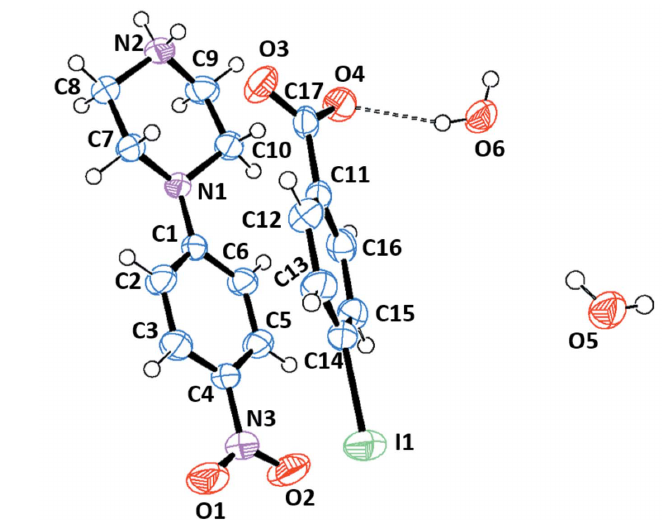
Figure 2 The independent components of compound (II) showing the atom- labelling scheme and the hydrogen bonds, drawn as dashed lines. Displacement ellipsoids are drawn at the 50% probability level.